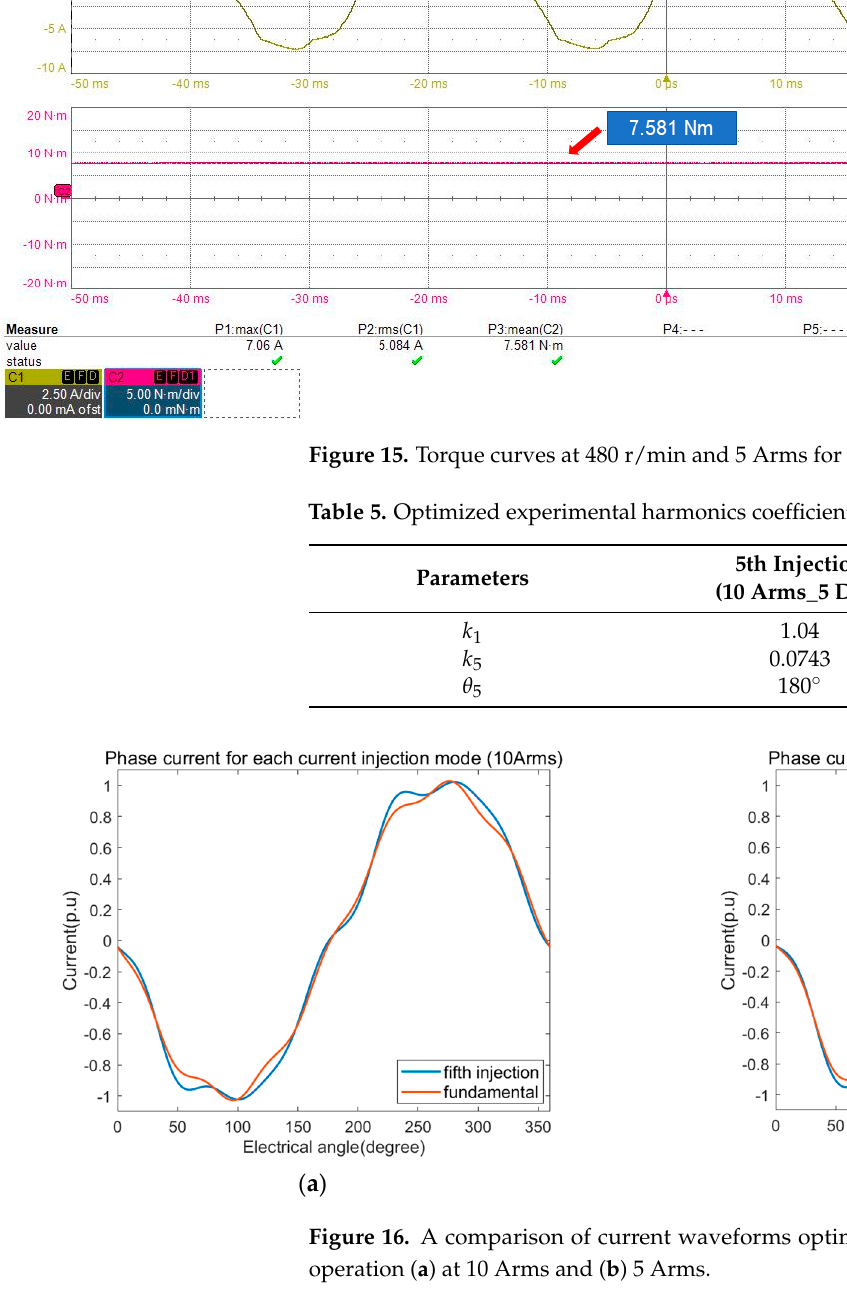
Table 5. Optimized experimental harmonics coefficient.